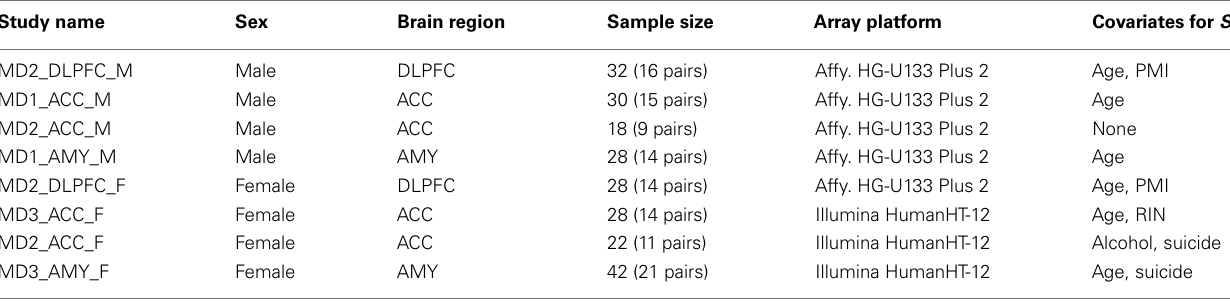
Table 1 | Data description of eight MDD microarray studies used for meta-analysis of SST results.